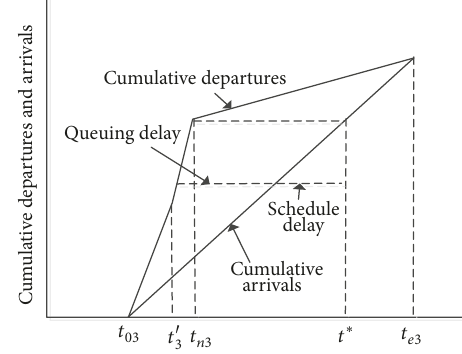
Figure 2:Cumulativedepartures and arrivals atequilibrium in Case